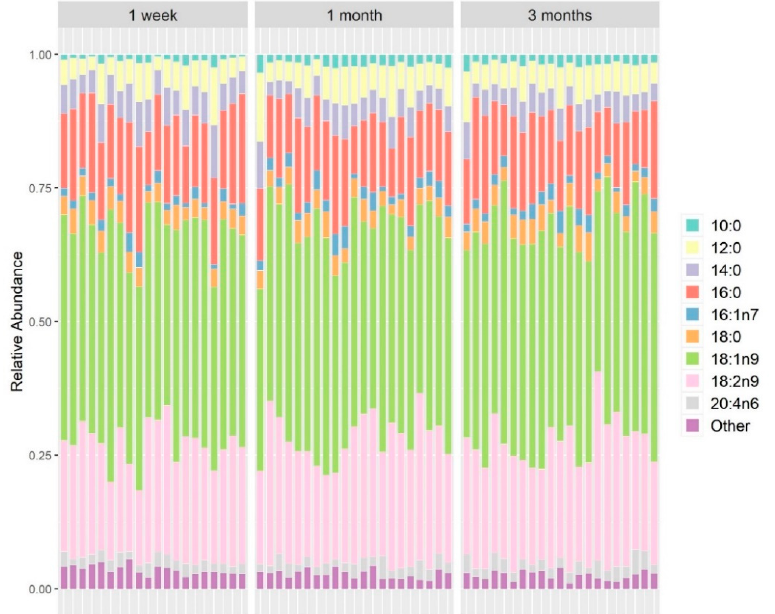
Figure 5. Fatty acids composition in the maternal milk samples. Fatty acids detected in quantities less than 2% (wt/wt) were grouped as “other”.